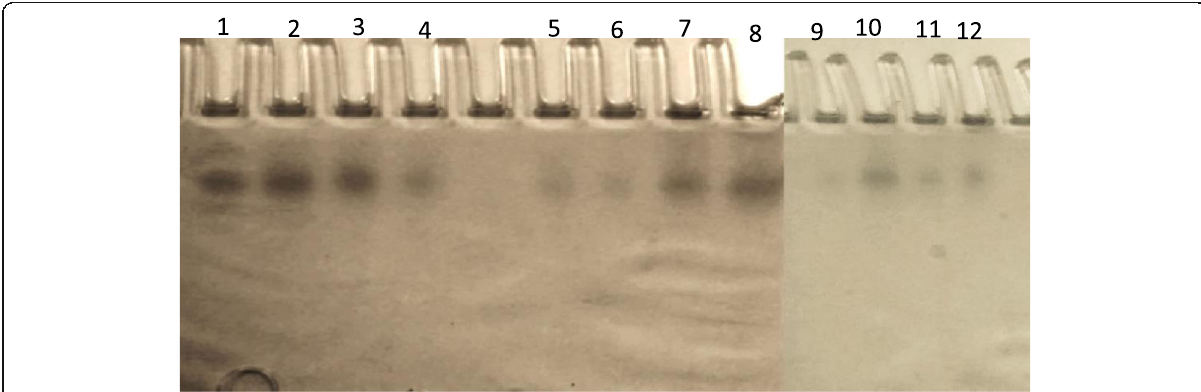
Fig. 5 Electrophoretic patterns of polyphenol oxidase isozymes for three lentil cultivars (G1, G2, G3) under control and treatment with different EMS doses. Lane1 = G1 (control), lane 2 = G1 (0.1 EMS), lane 3 = G1 (0.2 EMS), lane 4 = G1 (0.3 EMS), lane 5 = G2 (control), and lanes 6, 7, and 8 = G2 with 0.1, 0.2, and 0.3 EMS, respectively. Lane 9 = G3/(control) and lanes 10, 11, and 12 = G3 with 0.1, 0.2, and 0.3 EMS doses,